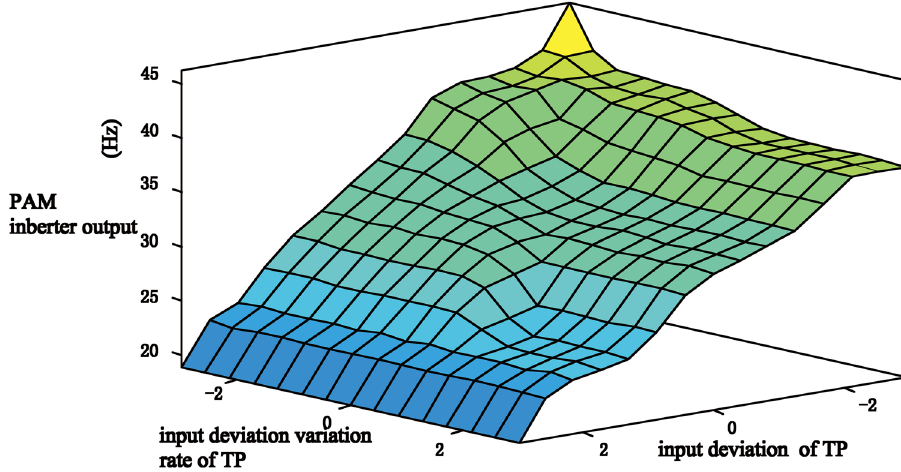
Fig. 6 PAC solution inverter’s output characteristic